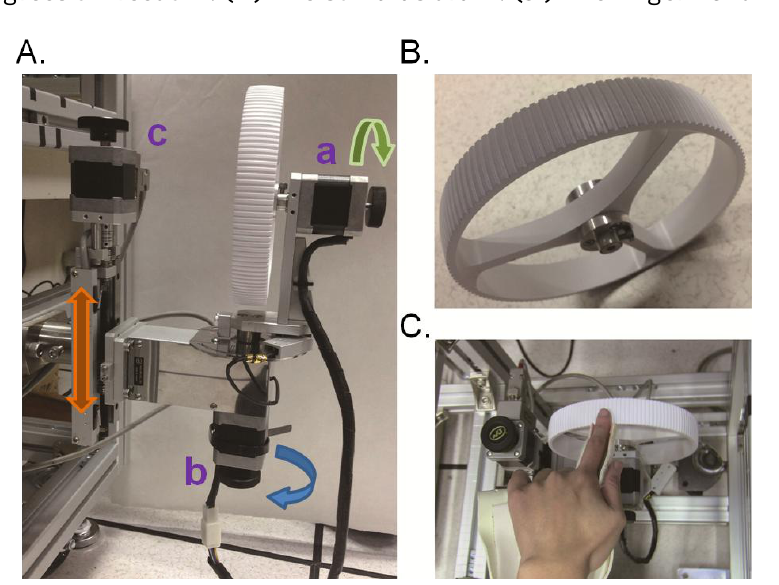
Figure 1. The tactile motion stimulator. ( A ) The three step motors (a, b and c) control each of the three degrees of freedom. ( B ) The stimulus drum. ( C ) The finger-hand